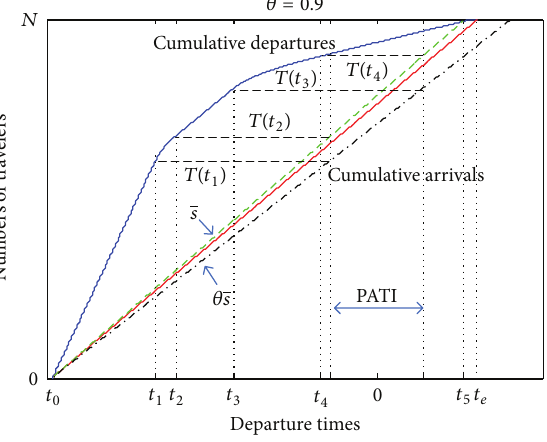
Figure 2: Departure time distributions in the stochastic